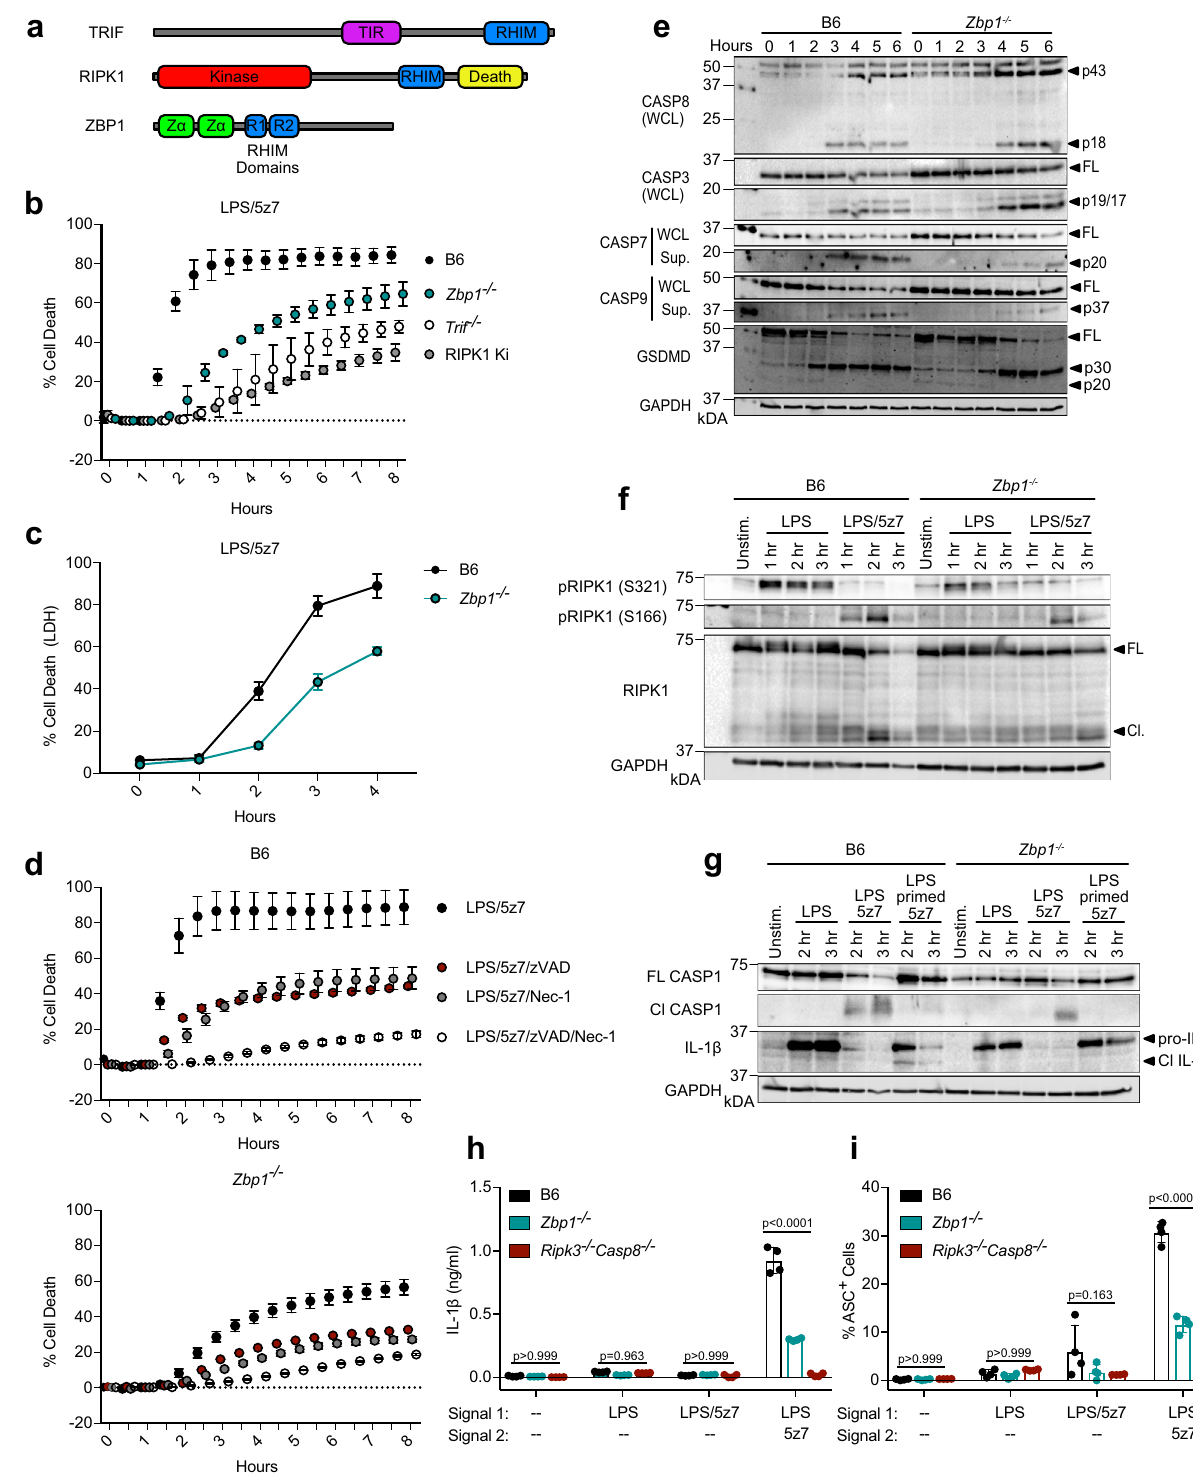
treatment resulted in cleavage of CASP8, 3, 7, 9, and GSDMD kinase activity, as treatment with the caspase inhibitor zVAD (Fig. 2e), indicating that ZBP1 is involved in the regulation of and/or the RIPK1 kinase inhibitor Nec-1 decreased death both apoptotic and pyroptotic cell death pathways in response to (Fig. 2d). This suggested that ZBP1 de fi ciency alters the kinetics LPS/5z7. While this was in stark contrast to the complete abro- and extent, but not the mode of cell death. While death was gation of caspase and GSDMD activation observed in Trif − / − , the delayed in the absence of ZBP1, TRIF-de fi ciency provided kinetics of these cleavage events were delayed by ZBP1 de fi ciency stronger protection, supporting a role for ZBP1 downstream of (Figs. 1c, 2e). Furthermore, TAK1 and MAPK-mediated TRIF-mediated signaling (Fig. 2b). In con fi rmation of the phosphorylation of RIPK1 at S321, and LPS/5z7-mediated mechanism of cell death occurring in Zbp1 − / − BMDMs, LPS/5z7 NATURE COMMUNICATIONS| (2021) 12:86